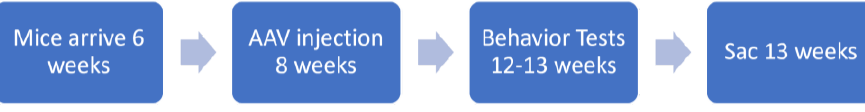
Figure 1. Timeline of the experimental